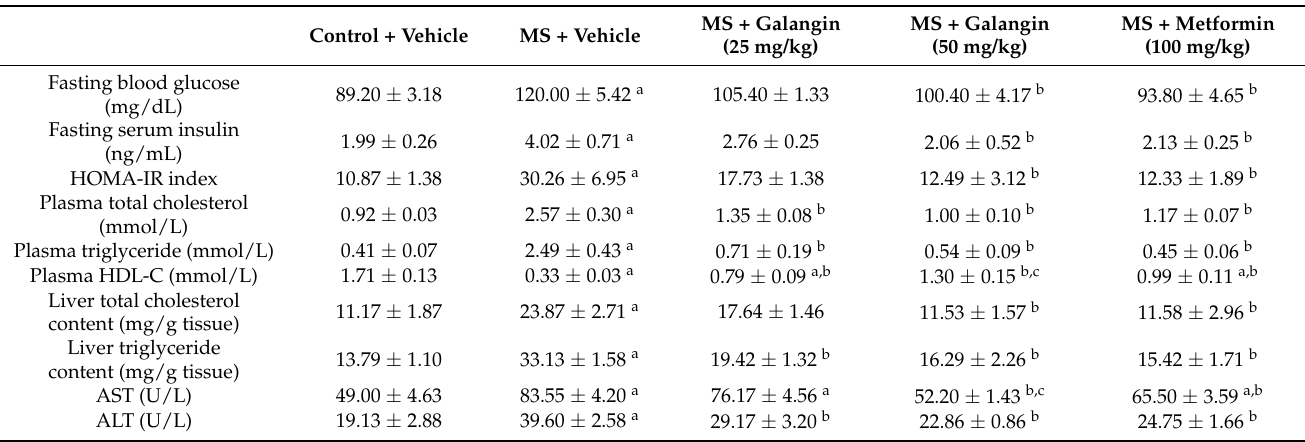
Table 2. Effects of galangin and metformin treatments on metabolic parameters in rats with high-fat diet-induced meta- bolic syndrome.